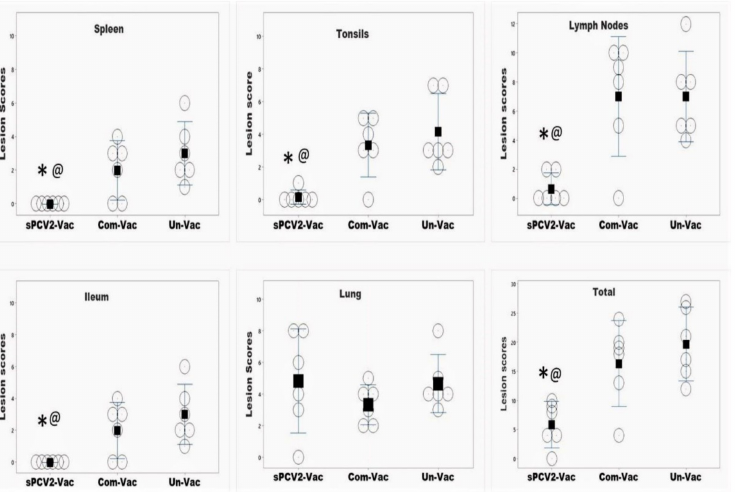
Figure 7. Lesion scores in the major organs: The lesion scores for the major organs recorded during necropsy at 21 days post-challenge are depicted as the sum of the gross, microscopic, and immuno- histochemistry scores for each tissue. X -axis—group, Y -axis—score, bars—95% confidence interval of the means, open circles—individual values, solid square—mean, * significantly different from the unvaccinated control group and, @ significantly different from the commercial vaccine control group by the Mann–Whitney U-test at p ≤